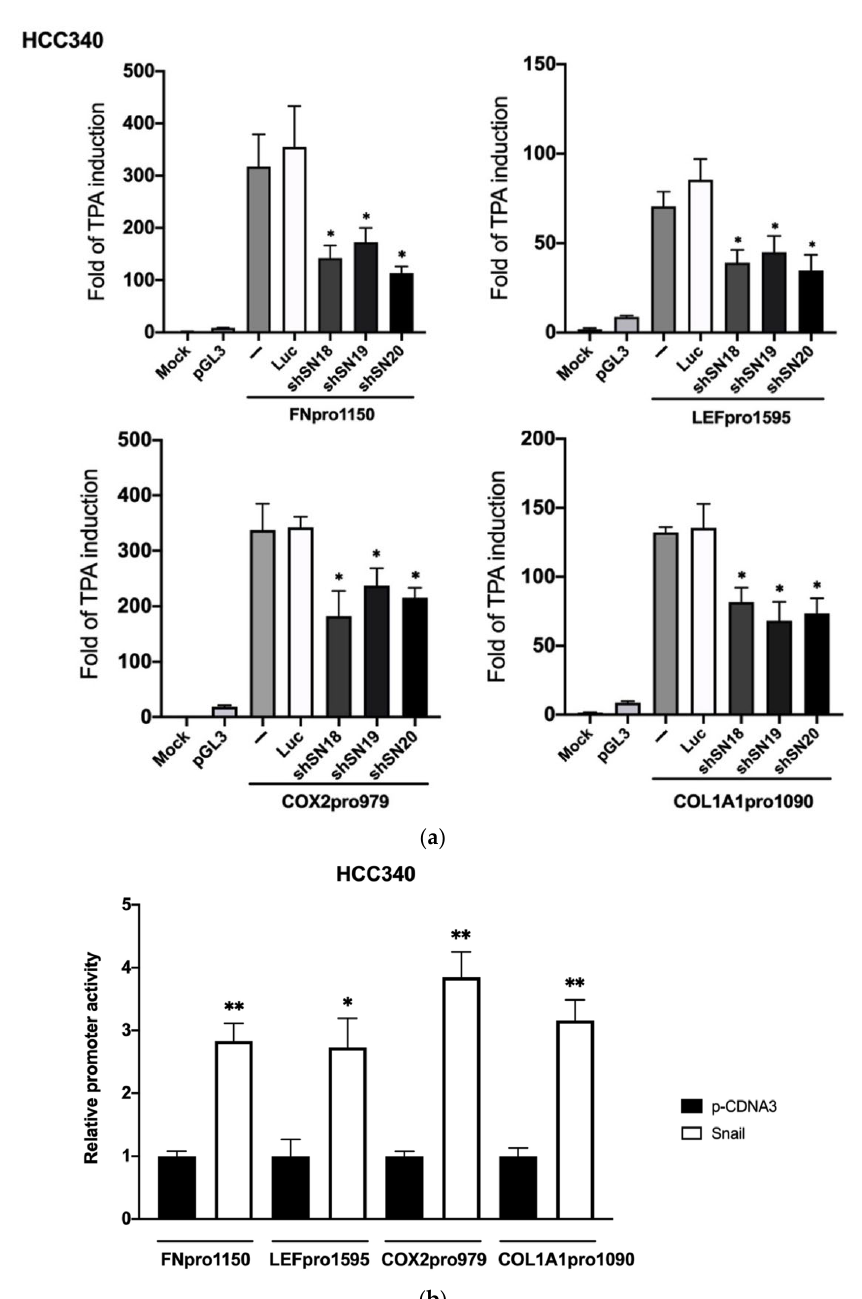
Figure 2. SNA is essential for constitutive and TPA-induced promoter activation of FN, LEF, COX2, and COL1A1. ( a ) HCC340 cells were untransfected (MOCK), transfected with PGL3 vector or full-length promoter of FN (upper left panel), LEF (upper right panel), COX2 (lower left panel), or COL1A1 (lower right panel) coupled with none ( − ), luciferase (Luc) or various SNA shRNAs as indicated for 16 h. Subsequently, the cells were treated with TPA for 12 h. MOCK is the nontransfected and no TPA-treated sample. Dual-luciferase activity was performed. For each full-length promoter, the fold of TPA induction was calculated by comparing the activity of each sample with the data of MOCK. ( b ) HCC340 were transfected with none (MOCK), p-cDNA3, or SNA expression plasmid for 24 h, followed by transfection of full-length promoter of FN, LEF, COX2, or COL1A1 for 16 h. Dual-luciferase was performed. For each full-length promoter, relative activity was calculated, taking the data of p-cDNA3 ( b ) as 1.0. In ( a , b ), (*, **) represent the statistically significant difference ( p < 0.05, p < 0.001, N = 3) between the indicated samples and Luciferase shRNA ( a ) or p-cDNA3 group ( b